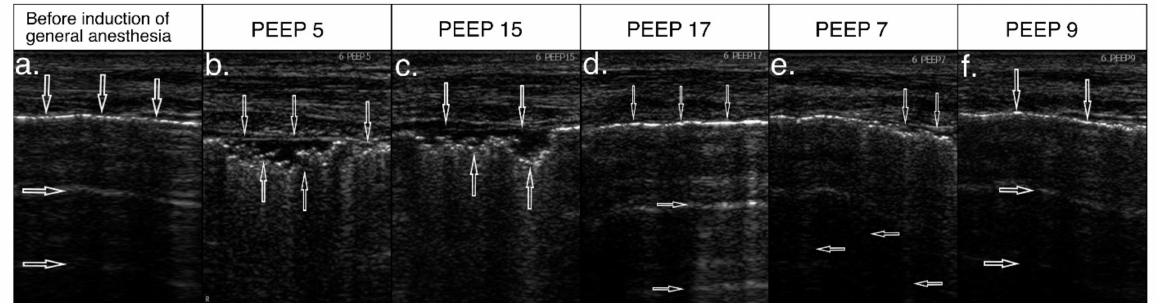
Figure 3. Recruitment process with a positive ultrasound effect. ( a ) Lung ultrasound (LUS) image before anesthesia— normal, hyperechoic pleural line ( ↓ ) and A-line artifacts ( → ), normal image; ( b ) control assessment during anesthesia, at positive end-expiratory pressure (PEEP) 5cmH 2 O—abnormal, fragmented pleural line ( ↓ ), subpleural consolidation ( ↑ ), A-line artifacts not visible, image characteristic for atelectasis; ( c ) when increasing PEEP to 15cmH 2 O —ultrasound features of atelectasis persist; ( d ) when achieving PEEP value of 17cmH 2 O—normal, hyperechoic pleural line ( ↓ ) and A-line artifact ( → ) visible again; ( e ) when reducing pressures, PEEP 7cmH 2 O—segmental disturbances in the pleural line continuity ( ↓ ) visible again and vertical artifacts reappear ( ← )—initial image of atelectasis; ( f ) after increasing end-expiratory pressure by 2cmH 2 O, disturbances in lung aeration reversed and normal pleural line and A-line artifacts were visualized.